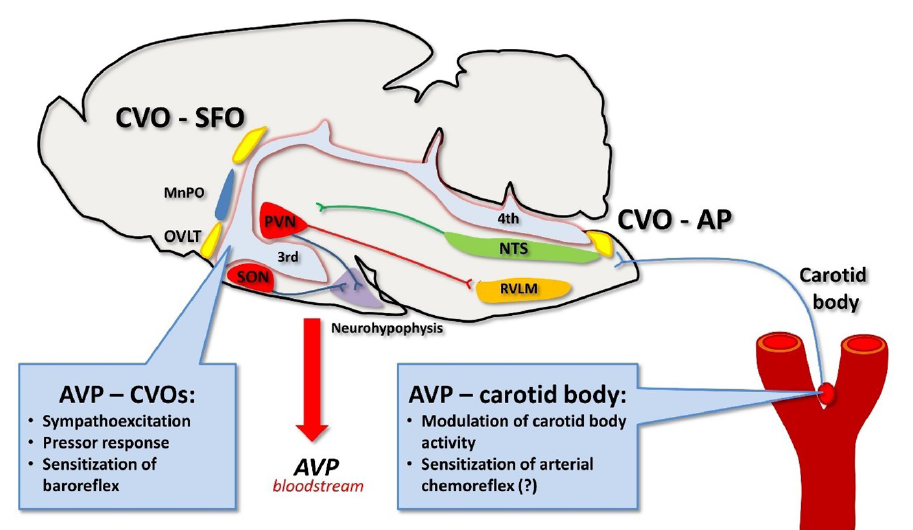
Figure 2. Vasopressin targets circumventricular organs and carotid body. Vasopressin present in the bloodstream contributes to the neural control of cardiovascular system by binding to its receptors in the circumventricular organs in the brain.